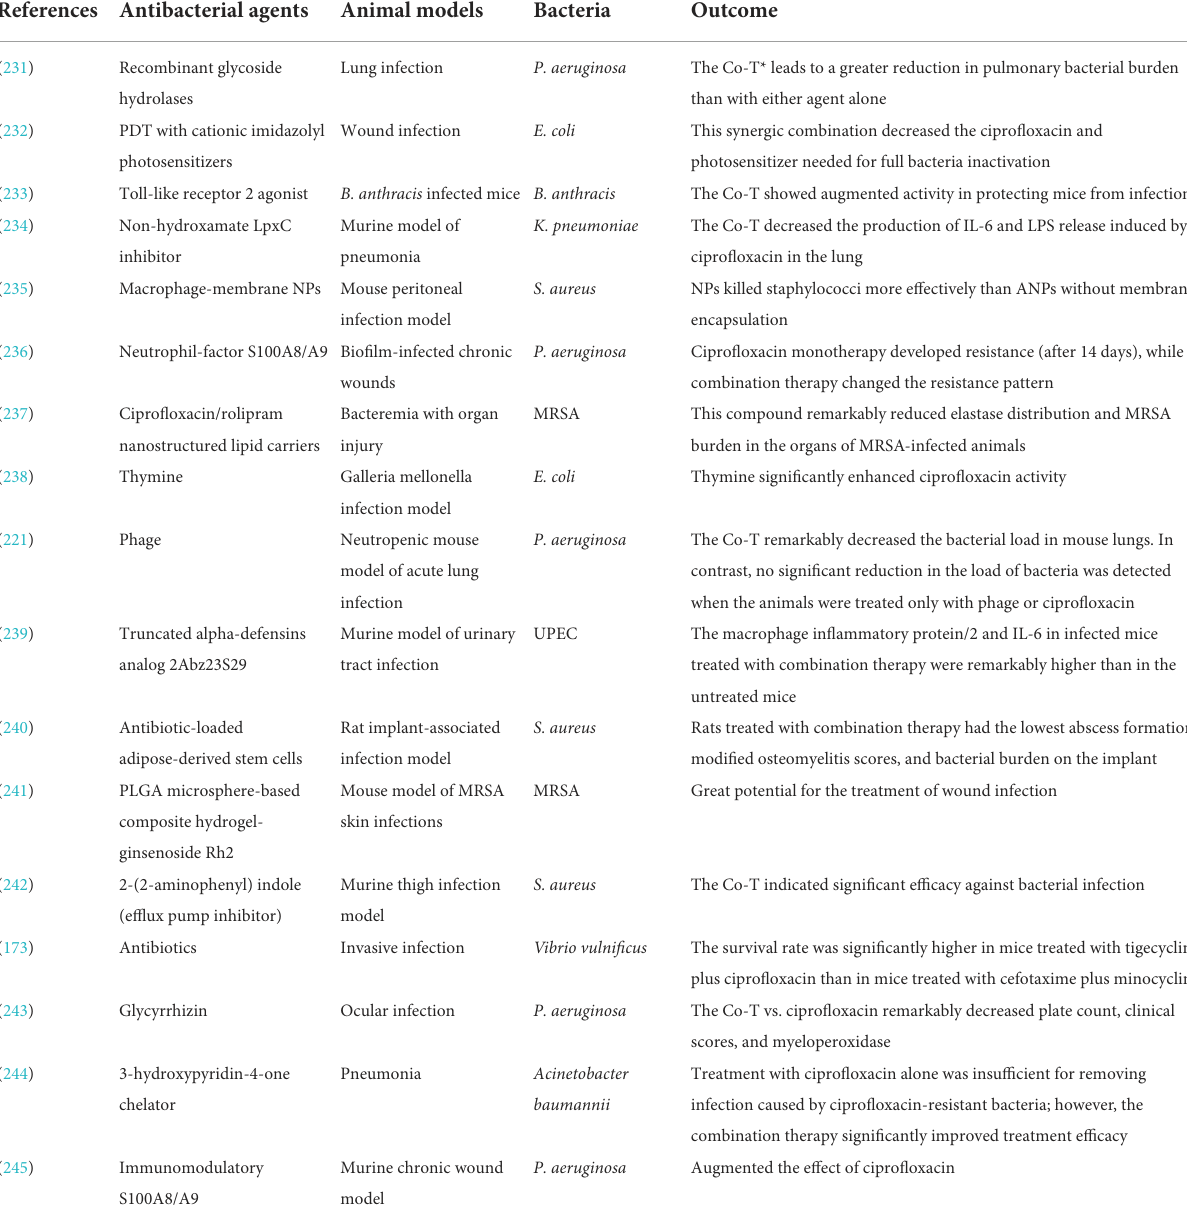
TABLE 5 Studies have used various approaches to enhance ciprofloxacin activity against bacterial infection in animal models and in vivo